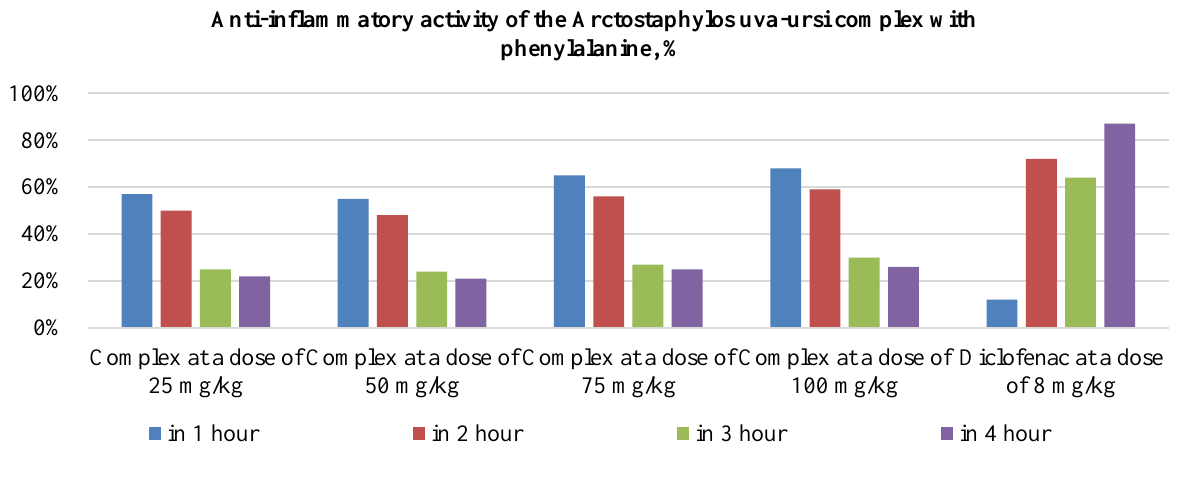
Fig. 8. Anti-inflammatory activity of the complex of Arctostaphylos uva-ursi extract with